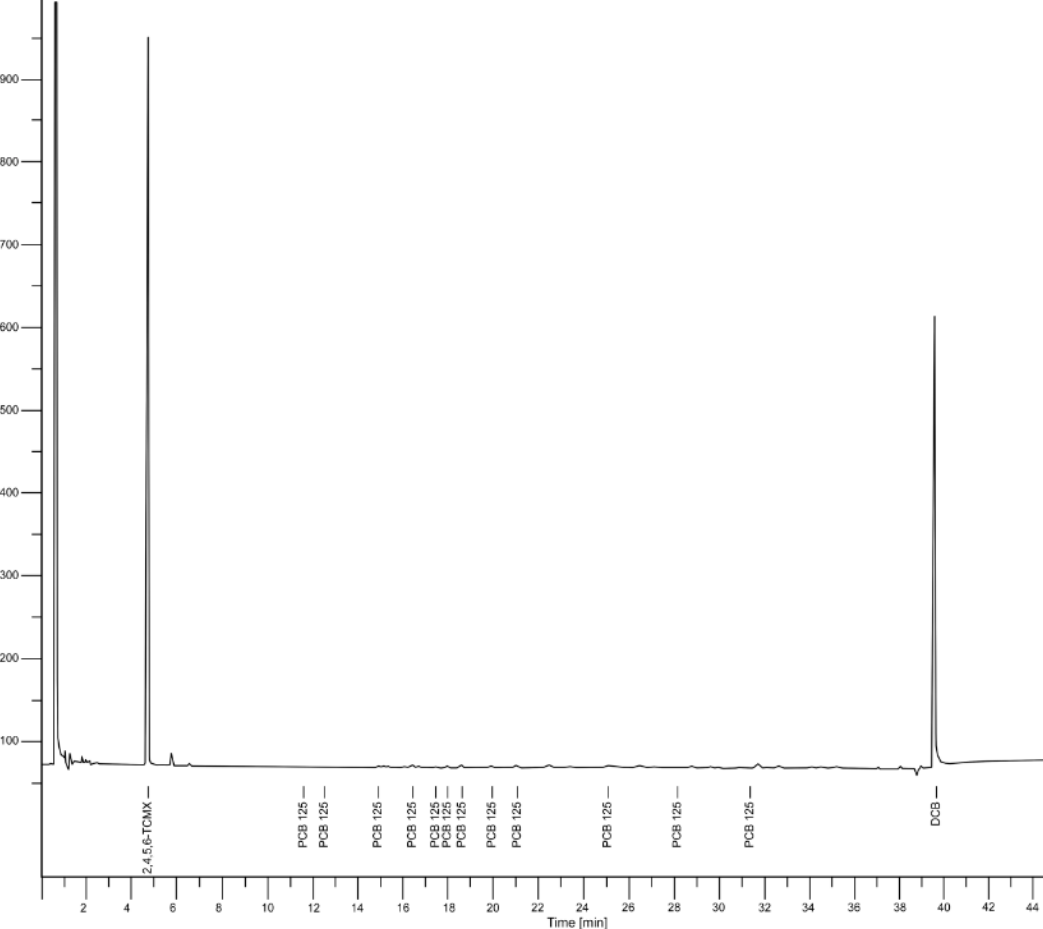
Figure 3. GC-ECD chromatogram of ASE blank extract, showing 2,4,5,6-tetrachloro-m-xylene and decachlorobiphenyl peaks and the elution times.